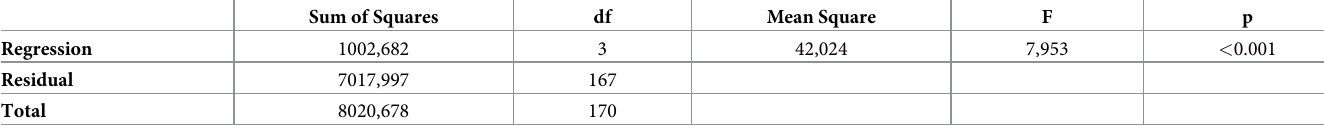
Table 5. Determination risk factors for the fear of COVID-19 scale with linear regression analysis.